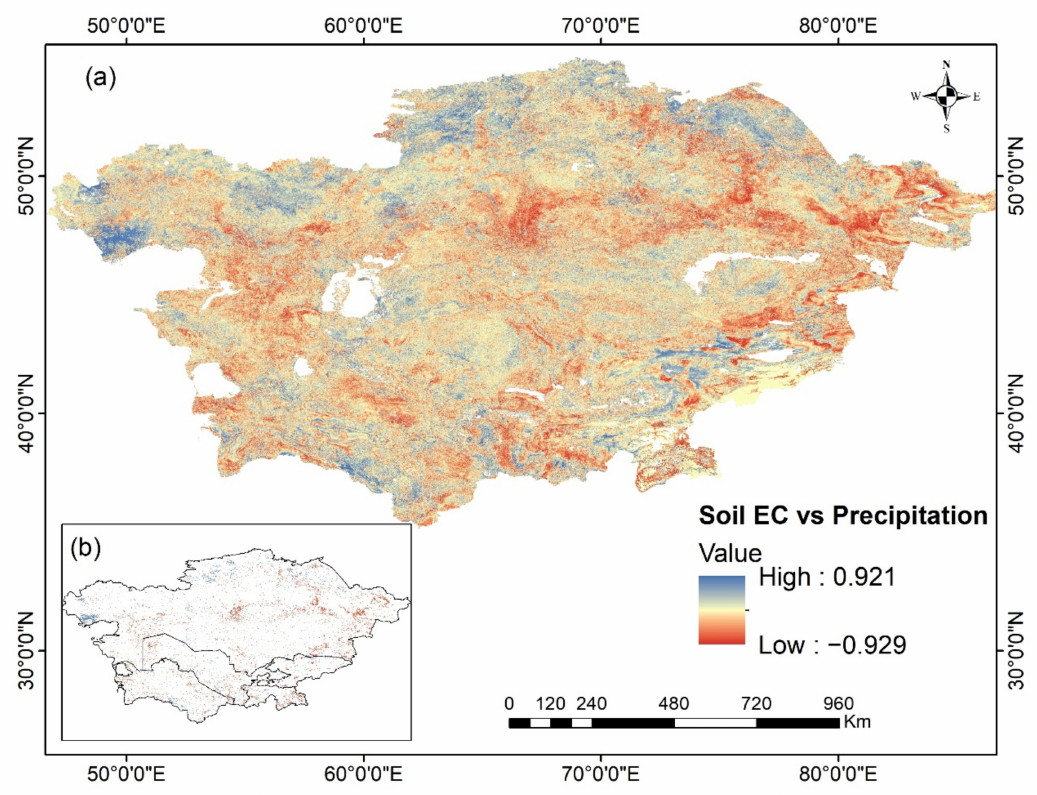
Figure 6. ( a ) Soil EC correlation to precipitation, and ( b ) significant changes during